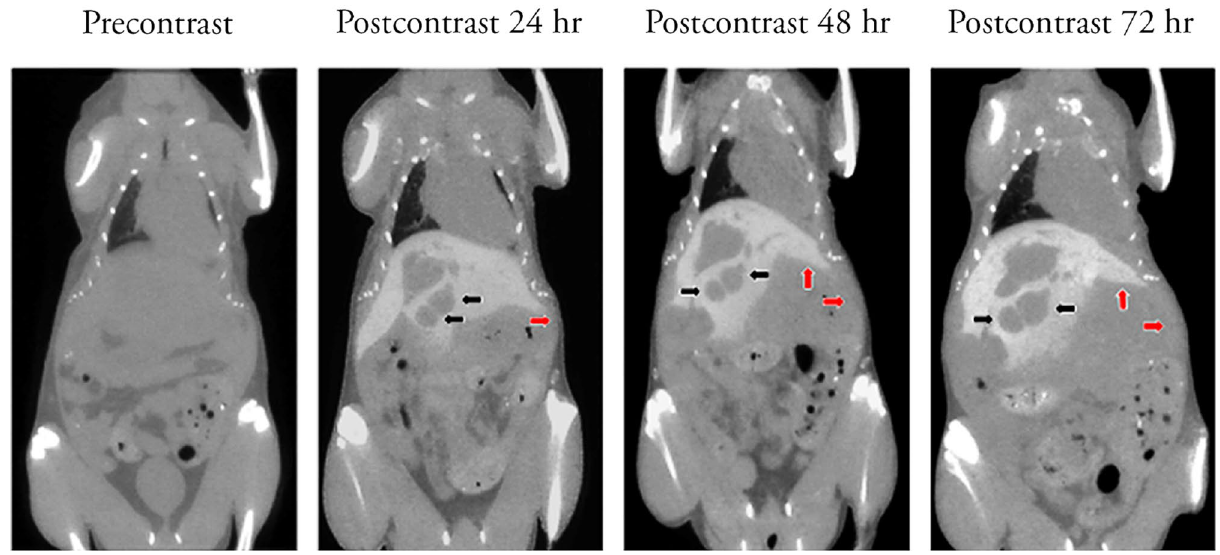
Figure 2. B16F10 tumor growth in the mouse liver observed using Fenestra HDVC. The murine melanoma cells grew in the mouse for two weeks before the mouse was given a single dose of Fenestra HDVC. Using in vivo micro-CT, the quantity and volume of tumors in the liver were measured for three days. The tumors measured for volume are indicated by the black arrows and the abnormal protrusion in the abdominal cavity and the liver is shown by the red